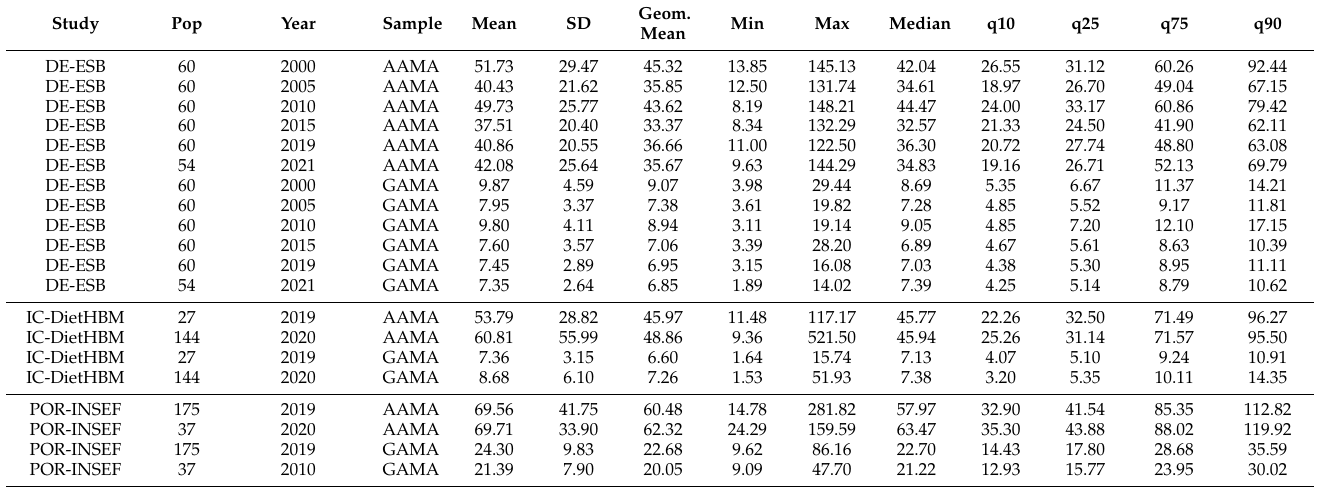
Table A7. Descriptive statistics of acrylamide biomarker levels per study and year (adults